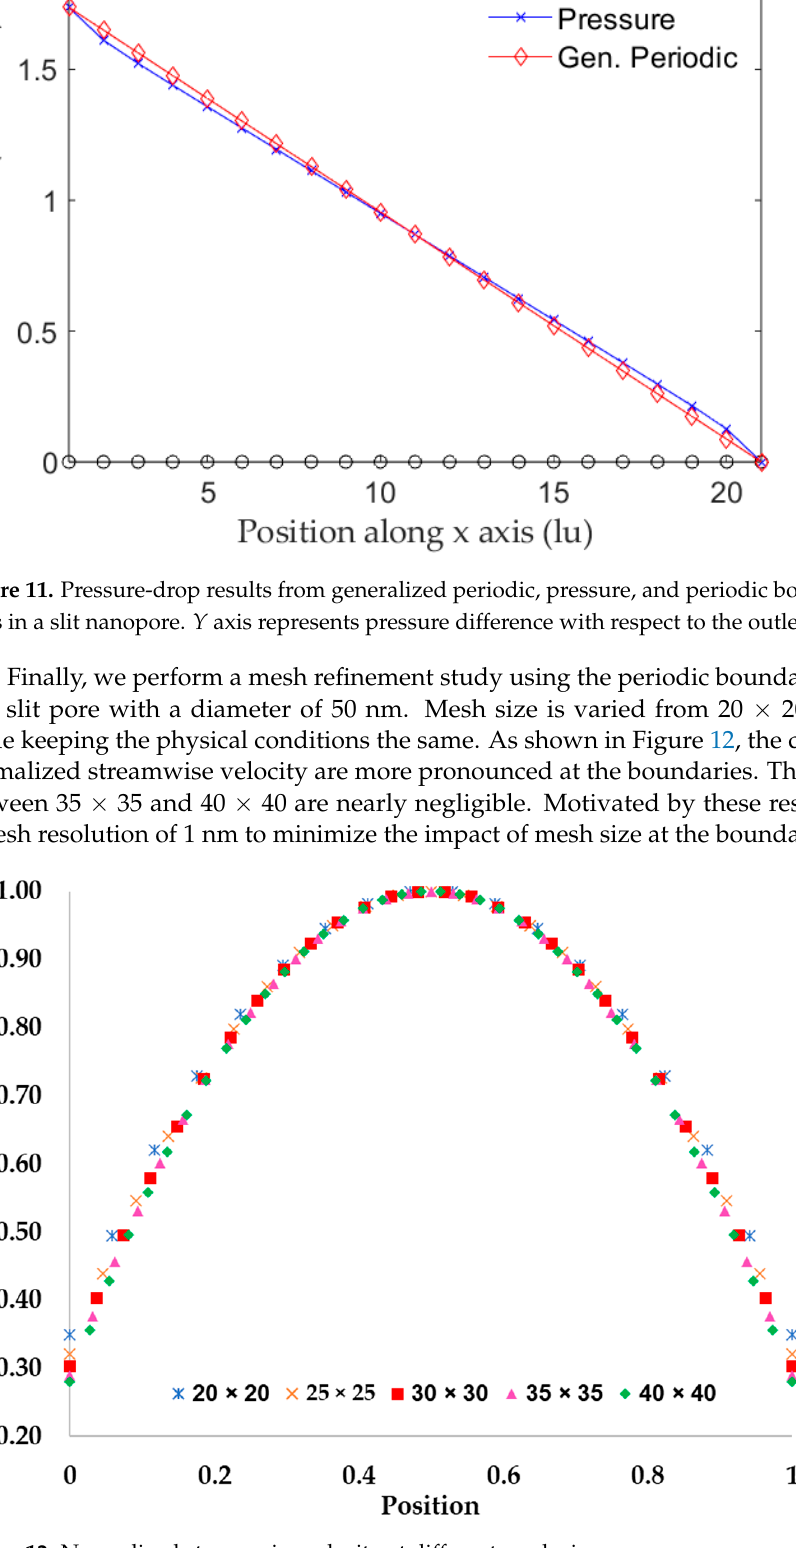
Figure 12. Normalized streamwise velocity at different mesh sizes.